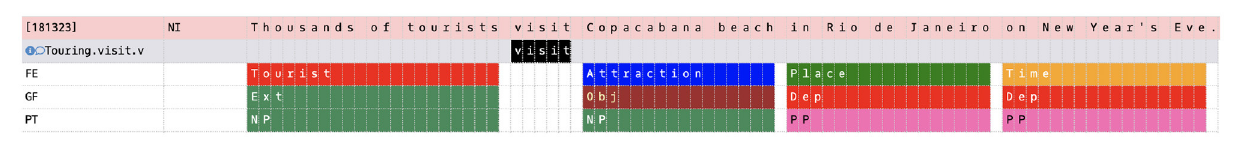
FIGURE 2 | Example of a FrameNet Annotation